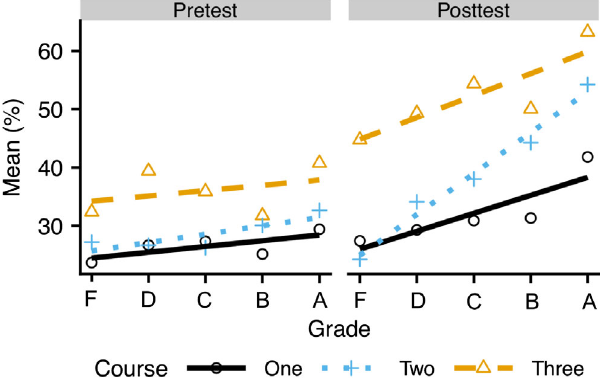
FIG. 6. Raw data and linear regression fit lines for average pretest and post-test scores for each grade for the three courses described by Nissen et al. [2].